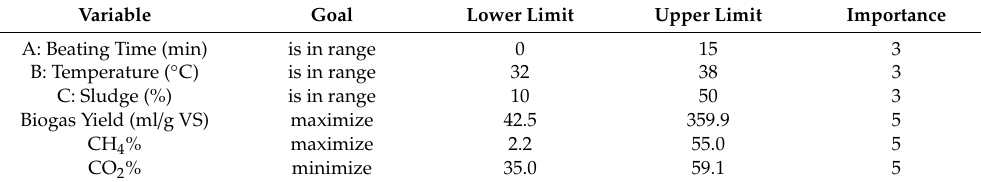
Table 20. Optimisation conditions for AD pot ale and spent grain mix.